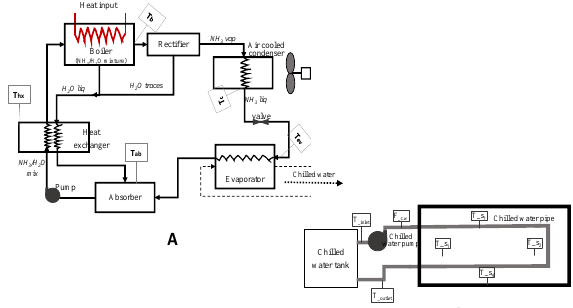
Figure 7: Schematic diagram of experimental set-up with temperature and flowrate measurement